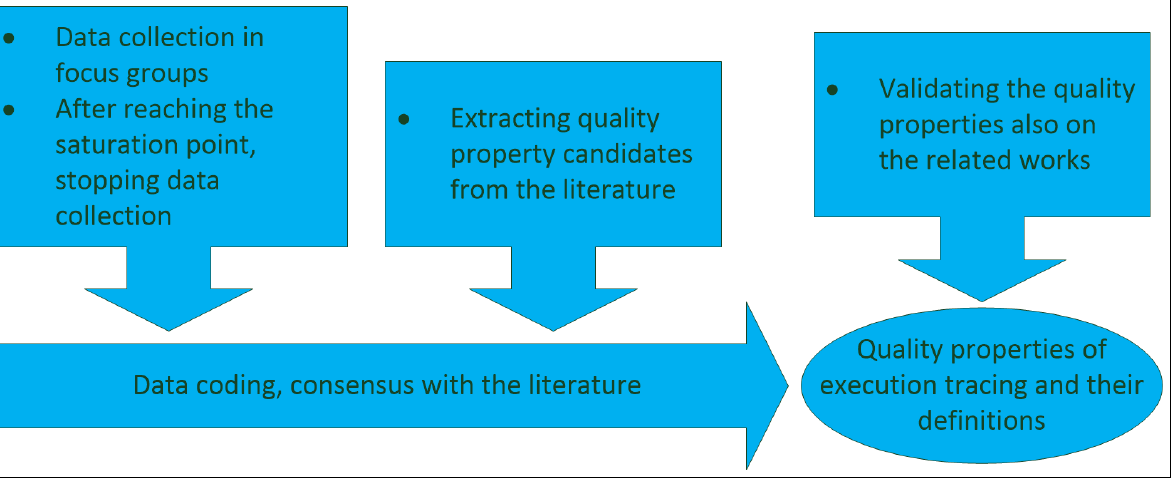
Figure 1. Identification of the Quality Properties of Execution